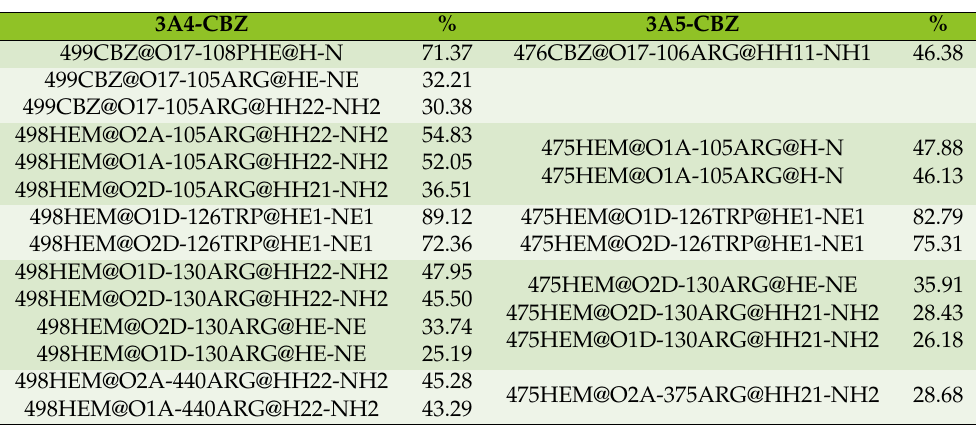
Table 1. Occupancy of the hydrogen bonds in two complex